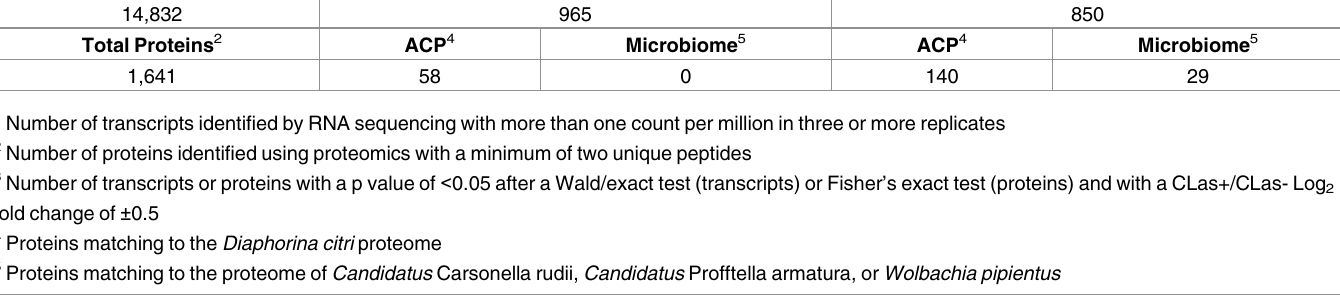
Table 1. Summaryof transcriptome and proteome data and differential expression. Total transcripts 1